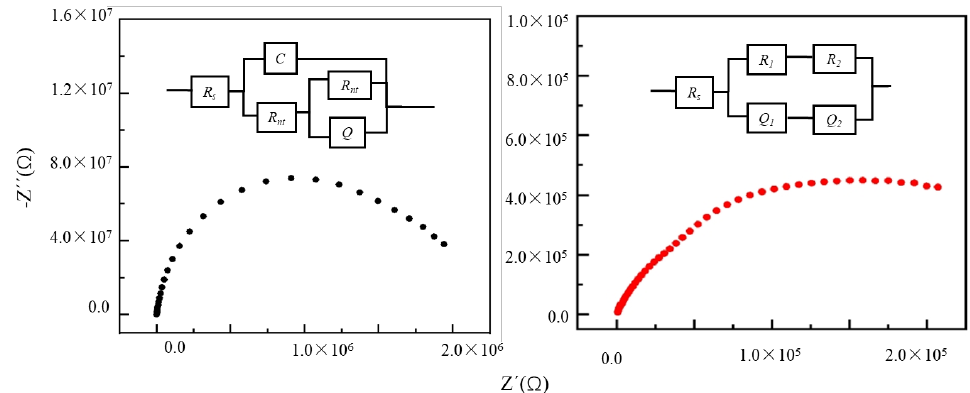
Figure 5. Nyquist plot of inner Au NRE 1 (black) and outer Au NRE 2 (red). The equivalent circuits are shown in the Inset. The electrolyte is 5 mM Fe (CN) 63-/4- in 1M KCl, tested at 10 mV amplitude, OCP, across a frequency range of 0.1 Hz-100 KHz.